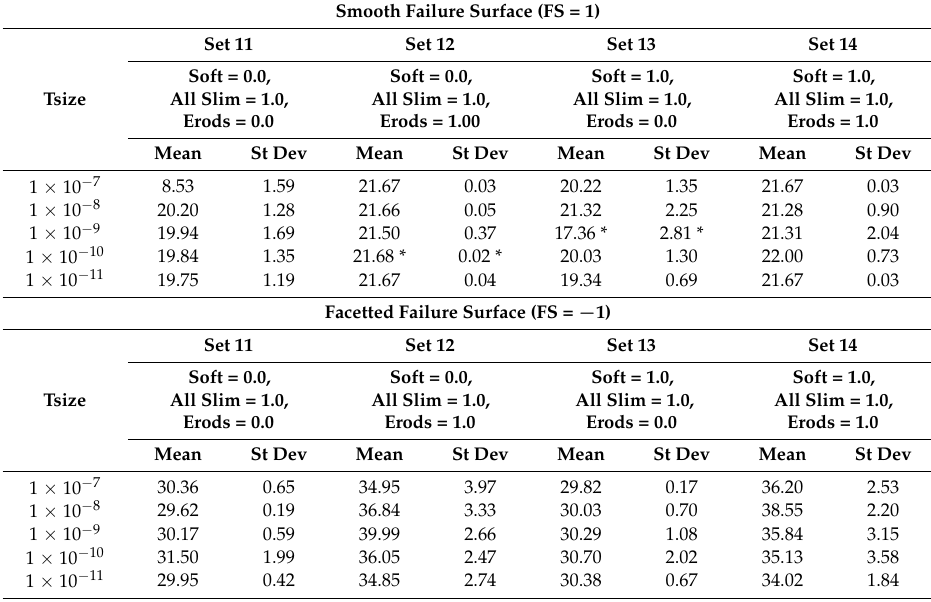
Figure 27. Investigation of time-step sensitivity with fourteen runs using the same model input file with All Slim = 1.0, TSize = 1 × 10 − 8 , Erods = 1.0, Soft = 1.0 and FS = − 1.0. Table 10. Mean and standard deviations (St Dev) for peak deceleration values (0.23 m < wall displacement < 0.29 m), for parameter sets 11 to 14, based on five runs for each given value. Smooth Failure Surface (FS = 1)